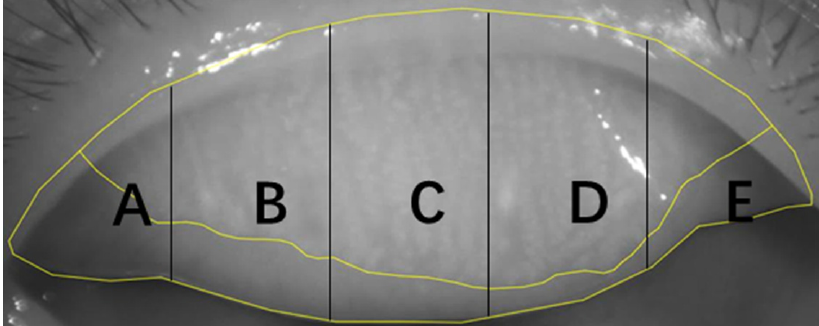
Figure 2. The computational method of UAS . UAS = | meibograde A − meibograde B | + | meibograde B − meibograde C | + | meibograde C − meibograde D | + | meibograde D − meibograde E | . The ABCDE represent different areas in tarsal plate.